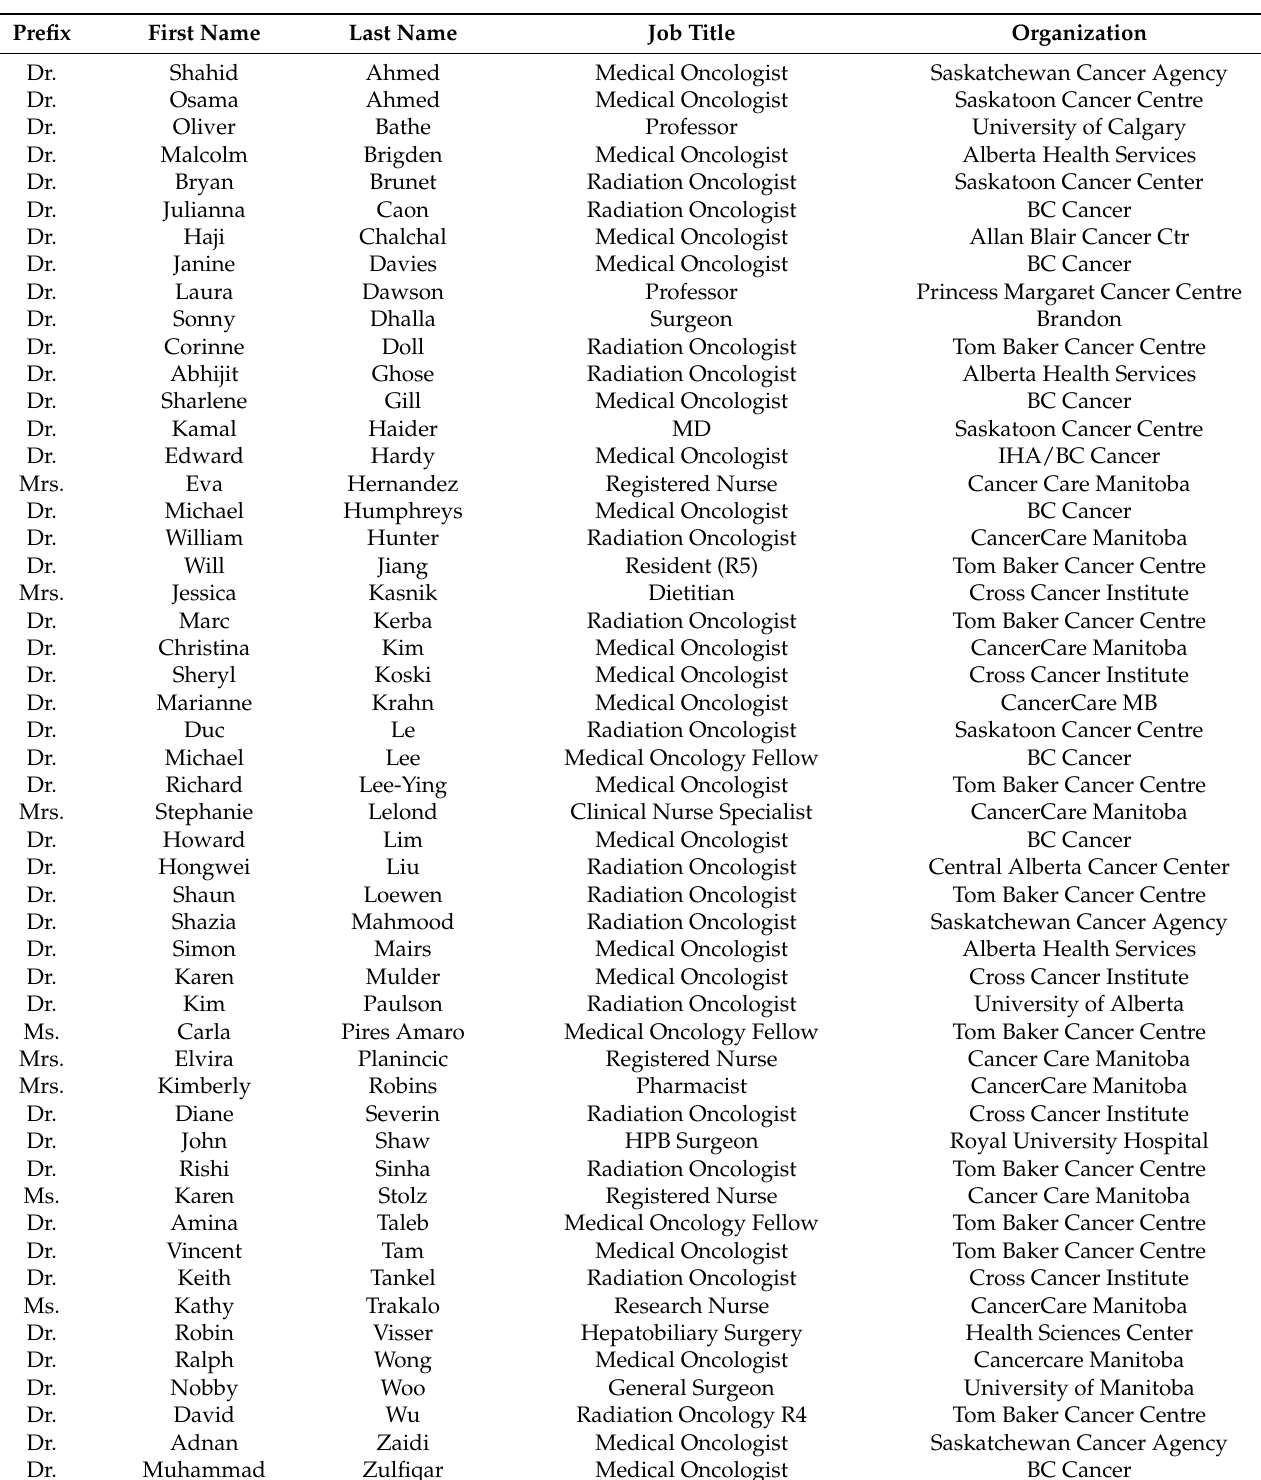
Table 1. List of 2019 WCGCCC